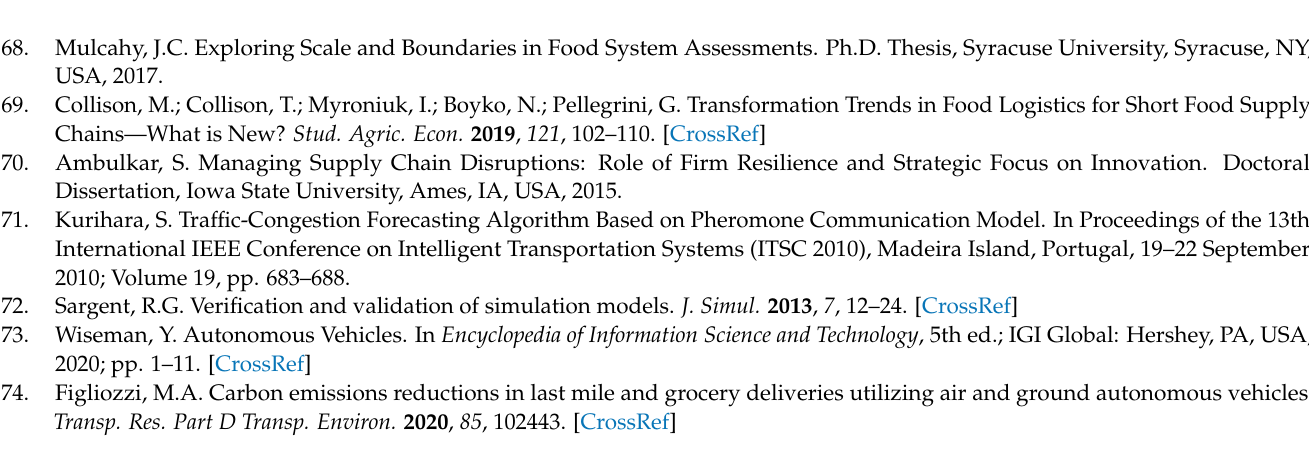
Figliozzi, M.A. Carbon emissions reductions in last mile and grocery deliveries utilizing air and ground autonomous